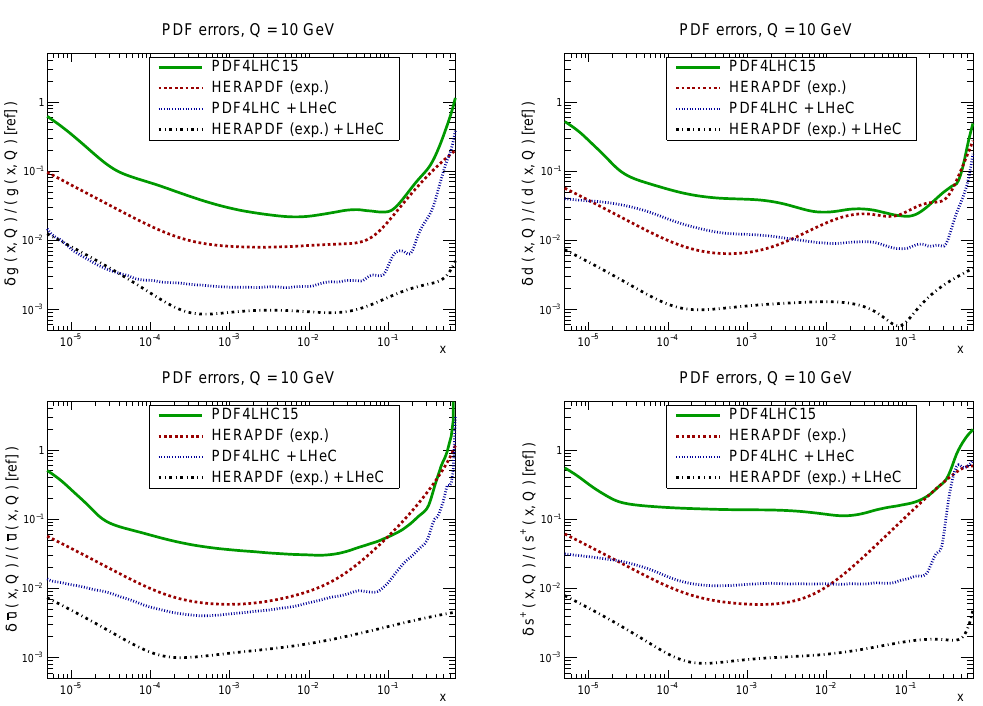
Figure 5.1: Same as Fig. 4.2, now comparing the impact of the LHeC pseudo–data when added on top of either the PDF4LHC15 or the HERAPDF2.0 sets. In both cases, a tolerance of T = 1 is used. For HERAPDF2.0, only experimental uncertainties are taken into account, while the model and parametric ones are not